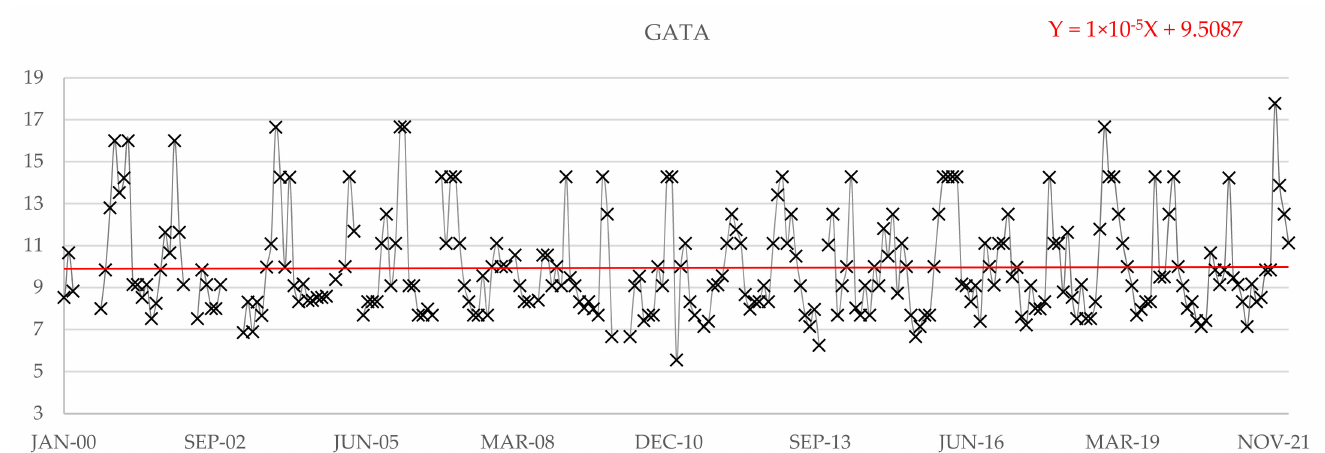
Figure 13. Evolution of Tp maxima in Cabo de